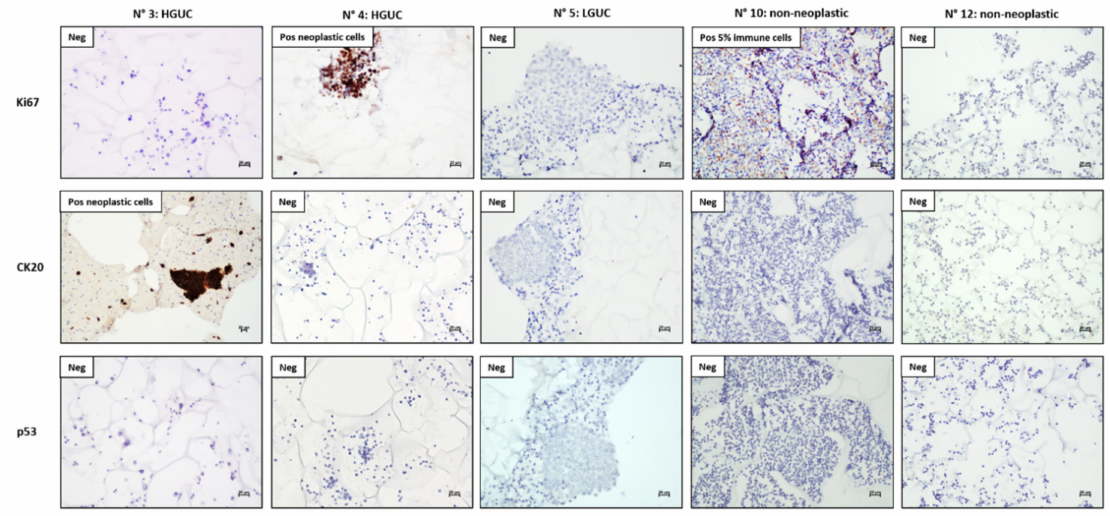
Figure 4. Automatic IHC on CytoMatrix-FFPE blocks. Panel of IHC at magnification 20x from different representative cases diagnosed as HGUC (N ◦ 3 and 4), LGUC (N ◦ 5), and non-neoplastic (N ◦ 10 and 12); images evidence the presence of one positive cases for CK20 (N ◦ 3), two for Ki67 (N ◦ 4 and 10) and none for